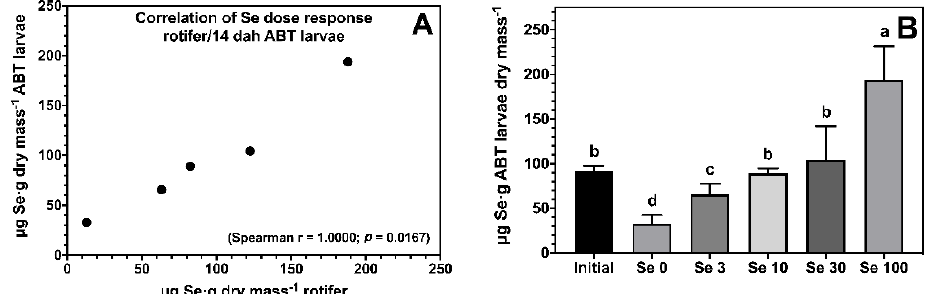
Figure 1. Dose response correlation between selenium levels in rotifers Brachionus rotundiformis grown on Algamac 3050 Bio Marine ® and enriched with 5 graded selenium levels (0, 3, 10, 30, and 100 mg of Se-yeast per 10 6 rotifers) and ABT larvae fed the rotifers from mouth-opening until 14 days post-hatching ( A ). Total body selenium levels ( n = 3; mean ± SD) measured in ABT larvae at the end of the feeding trial ( B ). Bars not sharing a common superscript letter indicate significant differences ( p < 0.05) between groups according to one-way ANOVA followed by Tukey’s